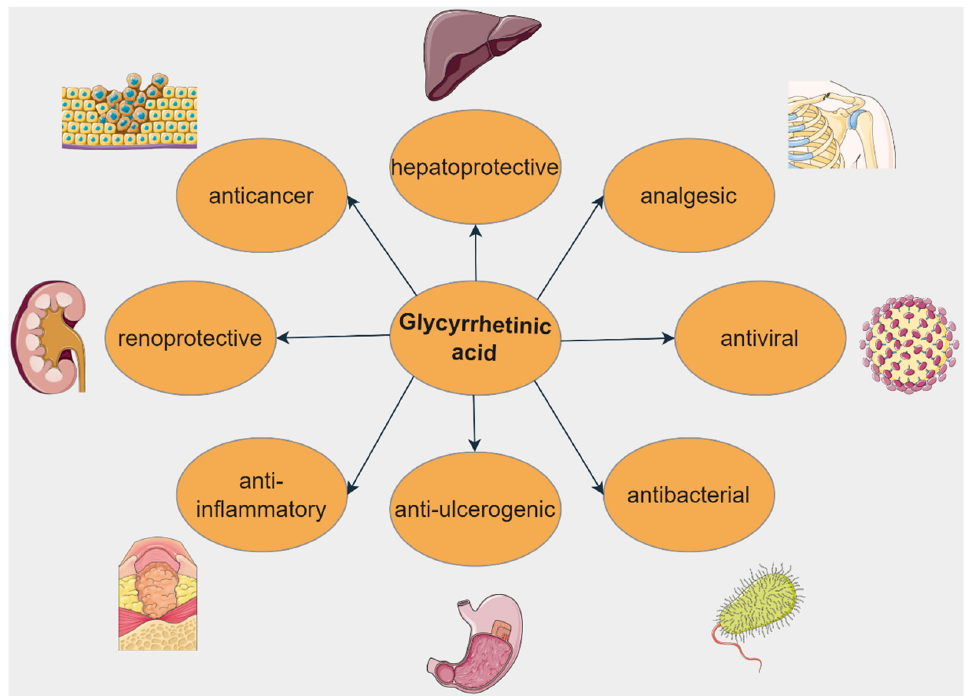
Figure 11. Biological activities of glycyrrhetinic acid. Parts of the figure were drawn by using pic-